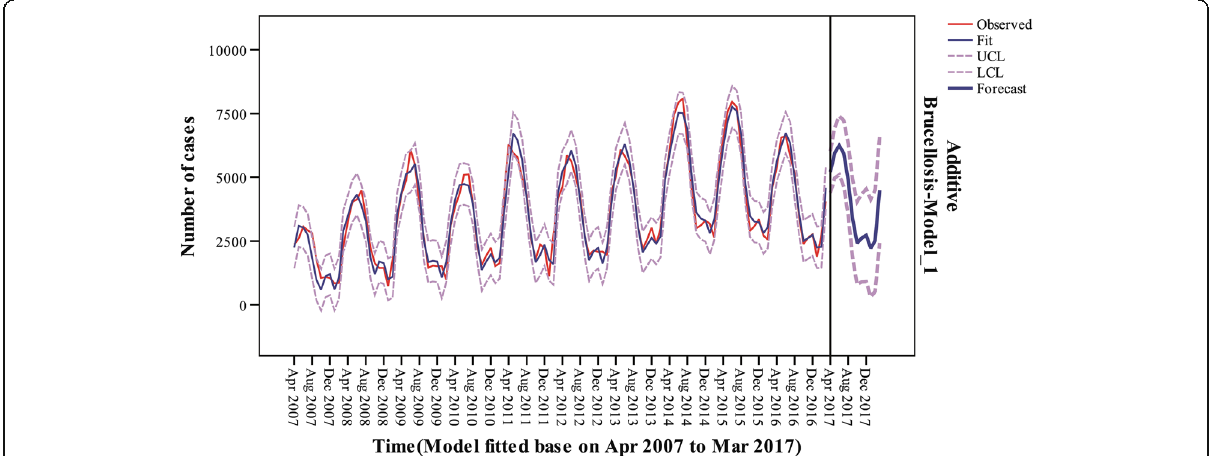
Fig. 5 Extrapolation prediction of the monthly reported cases between April 2017 to March 2018 in Mainland China, based on the additive